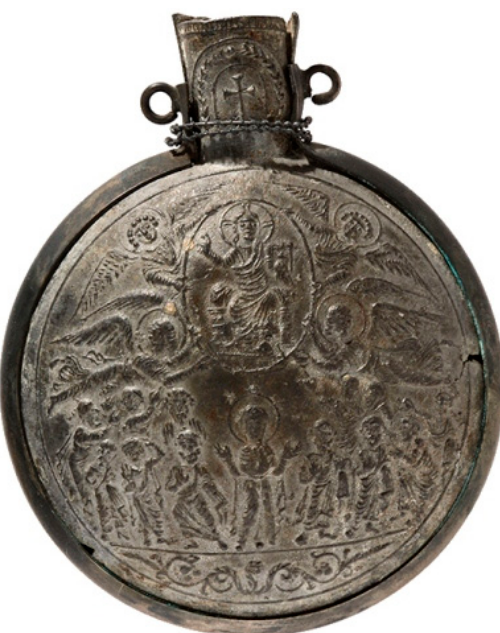
◦ 1ofMonza,reverse. 6thcentury. © TreasuryofMonzaCathedral(withkindpermission). Figure 13. Ampulla nº1 of Monza, reverse. 6th century. © Treasury of Monza Cathedral (with kind Figure 13. Ampulla n